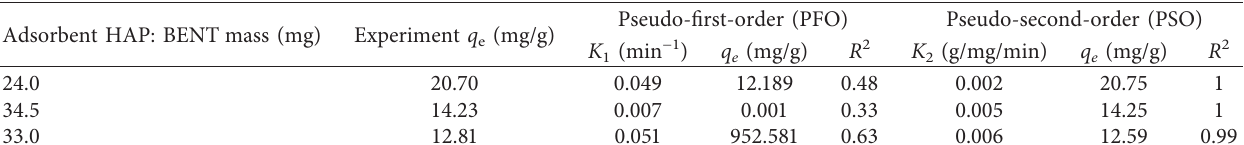
Table 4: Kinetic model parameters for adsorption of MB.